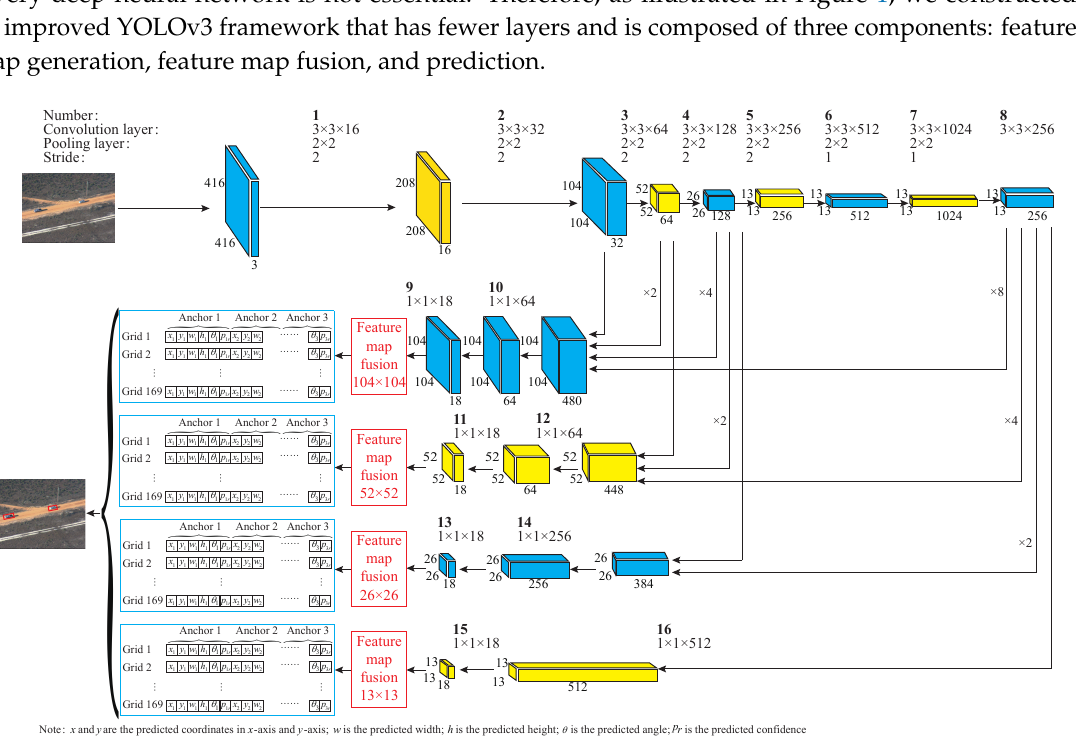
Figure 1. The diagram of the improved YOLOv3 framework with four